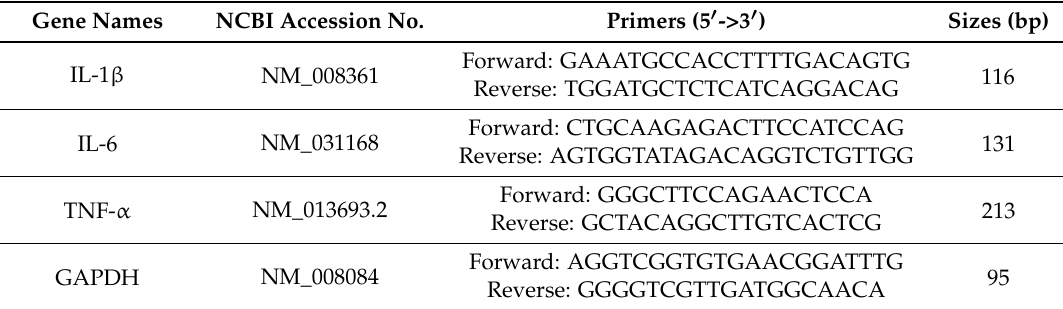
Table 4. Details of the genes tested, and the primers used for